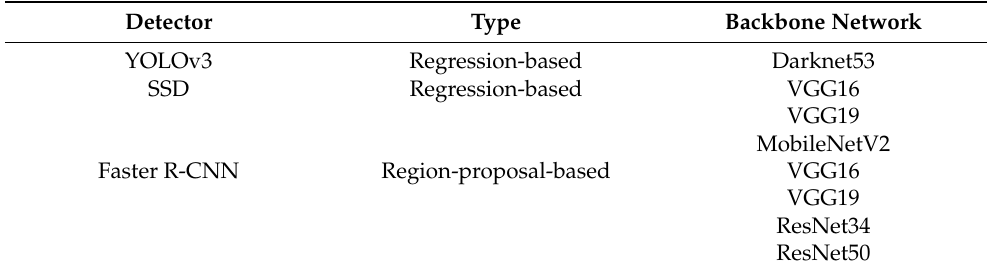
Table 1. Object detectors with various backbone networks selected for fault injection test. Detector Type Backbone Network YOLOv3 Regression-based